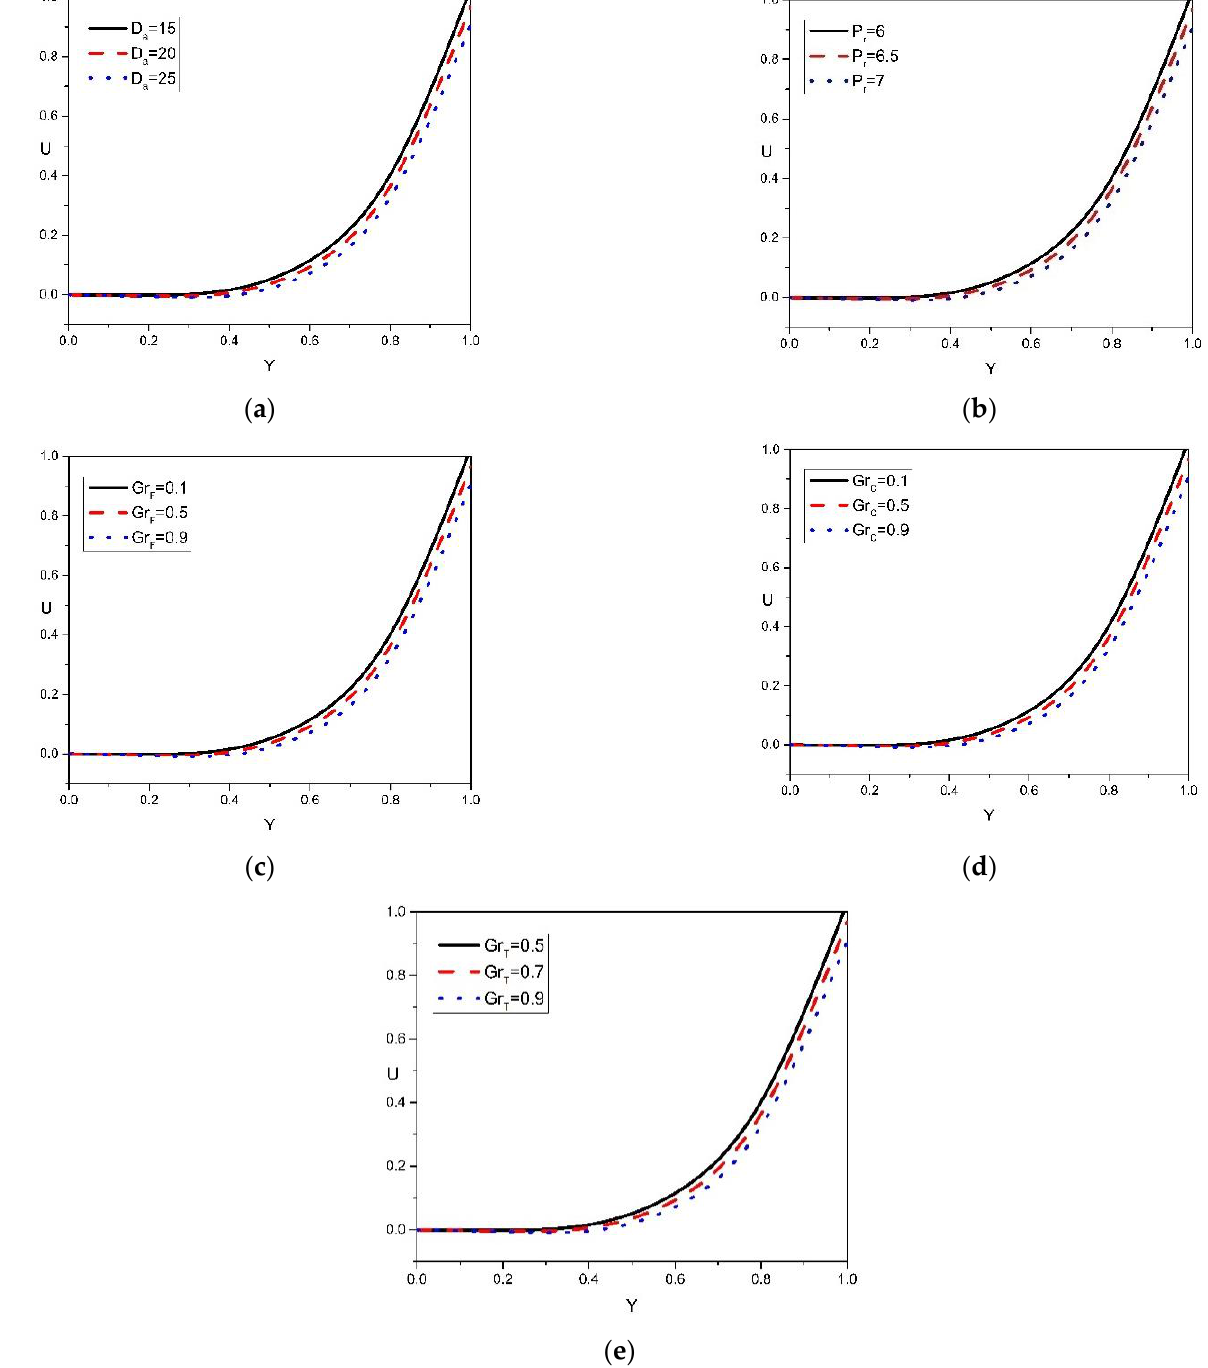
Figure 2. ( a – e ) Velocity distribution versus Y for various physical parameters ( a ) G = 0.5, G = 0.5, G = 0.5, N = 0.7, N = 0.7, N = 0.5, N t = 0.5, P r = 7, λ rT rF rC CT TC b M = 0.2. ( b ) G rT = 0.5, G rC = 0.5, G rF = 0.5, N CT = 0.7, N TC = 0.7, N b = 0.5, N t = 0.5, D a =